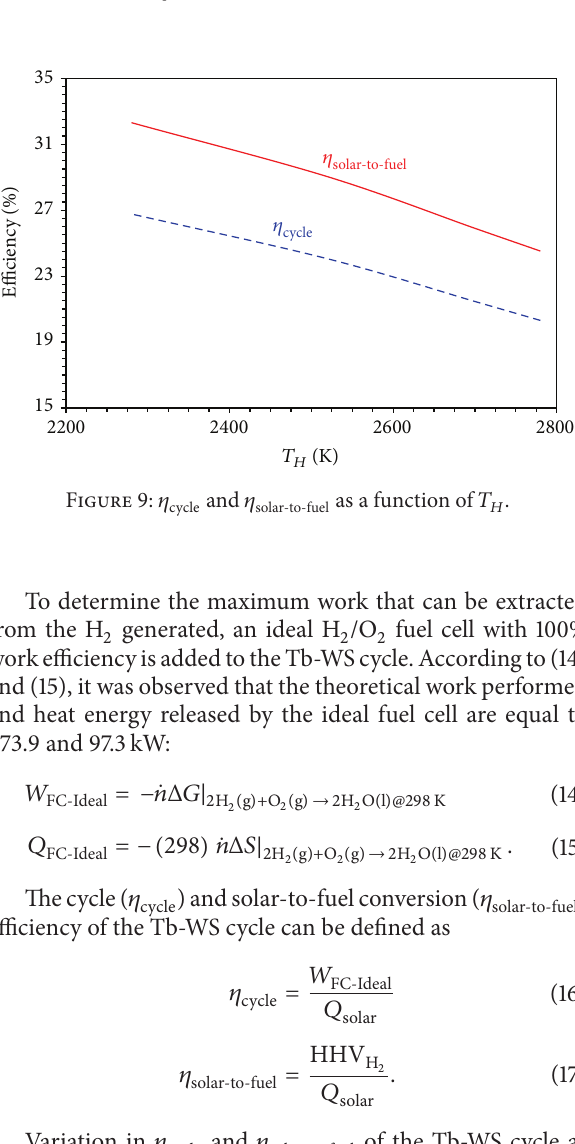
and (b) 𝑄 . reradiation quench